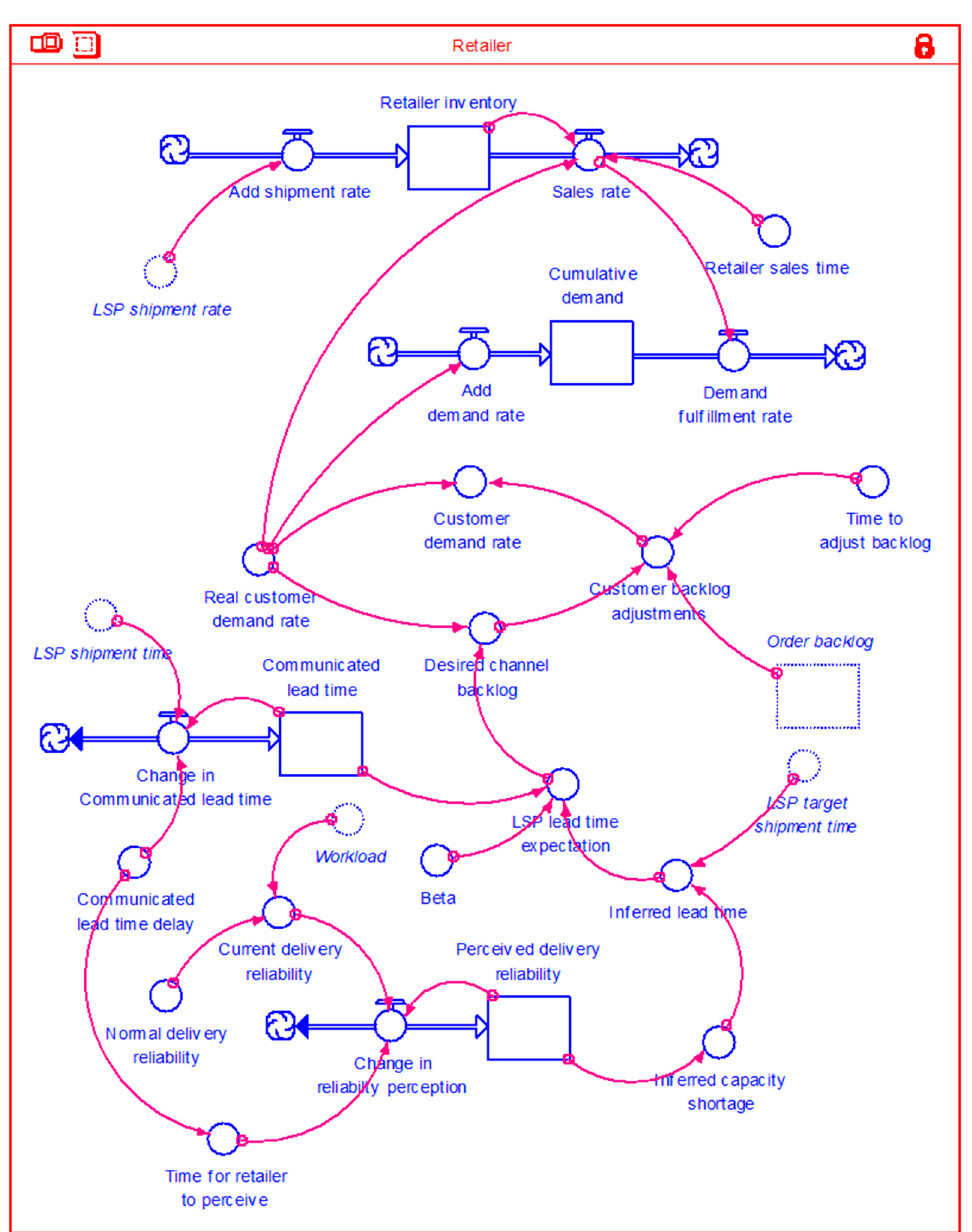
Figure 4. Retailer’s order fulfillment simulation model for Scenario 1.